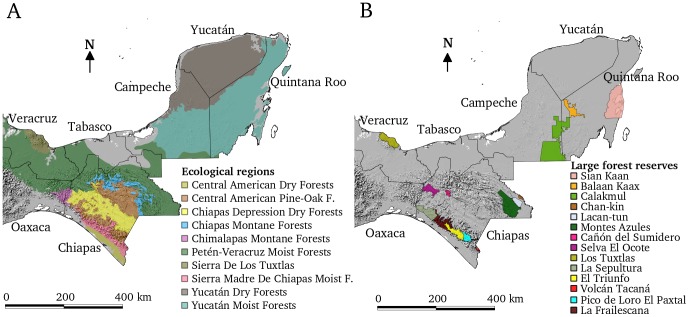
Study area.A) Ecological regions of Southern Mexico as proposed by Olson et al. [37]: gray areas consist in areas excluded from analysis. B) Large forest reserves.